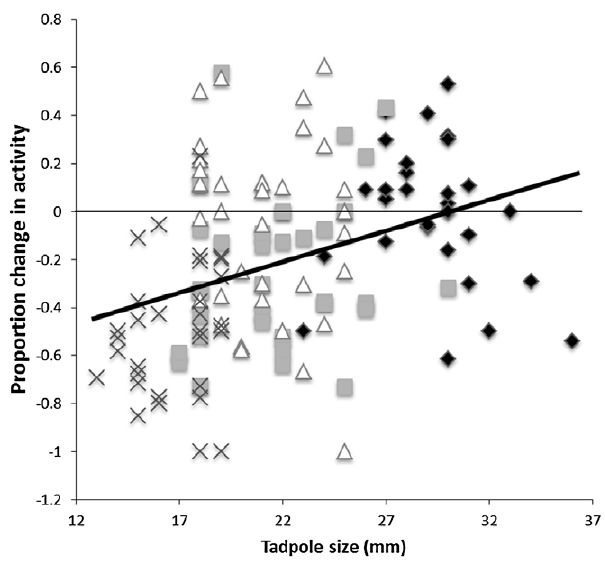
Figure 4. Scatterplot of the proportion change in activity of each tadpole exposed to salamander odour according to tadpole size. The fat solid line represents the regression line (R 2 =0.1, P , 0.001). Crosses represent small tadpoles maintained on a slow growth rate, triangle small tadpoles maintained on a fast growth rate, square large tadpoles maintained on the slow growth rate and diamonds large tadpoles maintained on a fast growth rate.